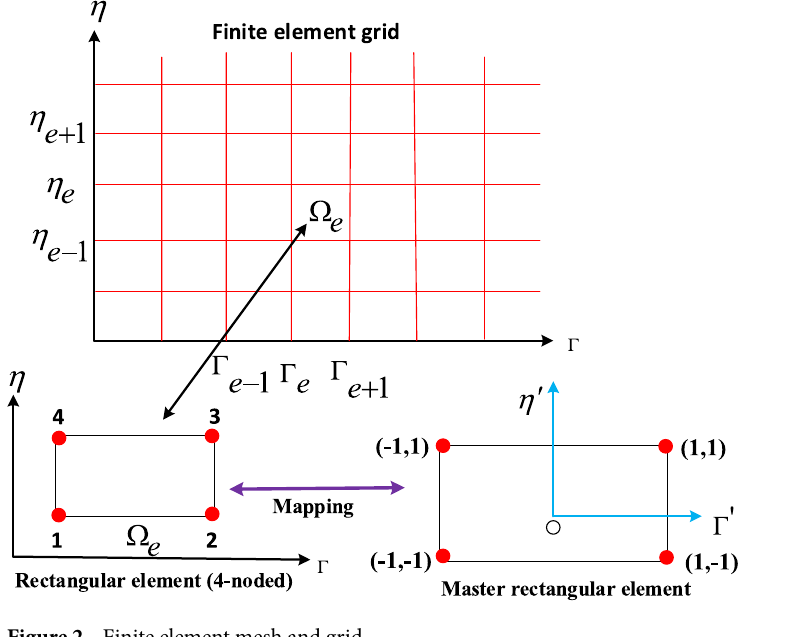
Figure 2. Finite element mesh and